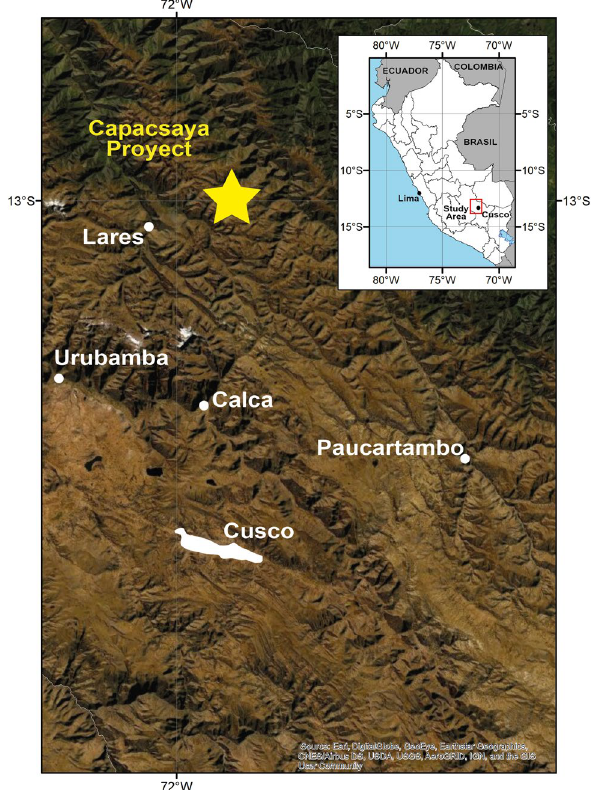
Fig. 1 Illustration of the location of Capacsaya site at northwest of Cusco (yellow star). Inset: Map of Peru indicating the coordinates in which Capacsaya site is located (red